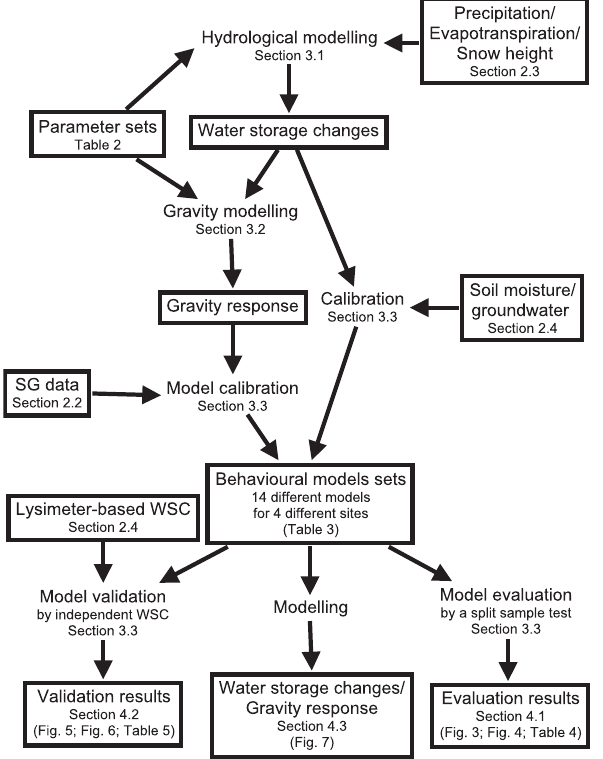
Fig. 1. Concept map (Ca˜nas et al., 2005) showing objects (boxes) and processes of this study in combination with the study structure.